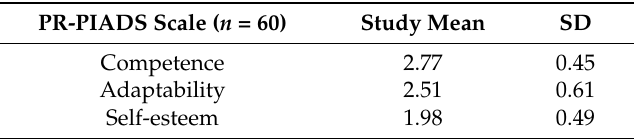
Table 5. Mean and standard deviations scores in each sub-scale of the Puerto Rican Psychosocial Impact of Assistive Device